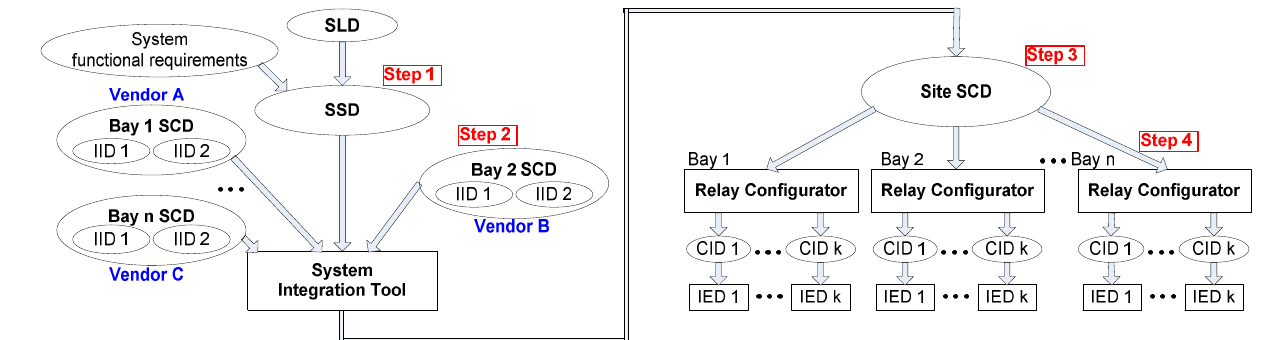
Figure 7. System integration process with the bay-solution approach and two stages engineering process.